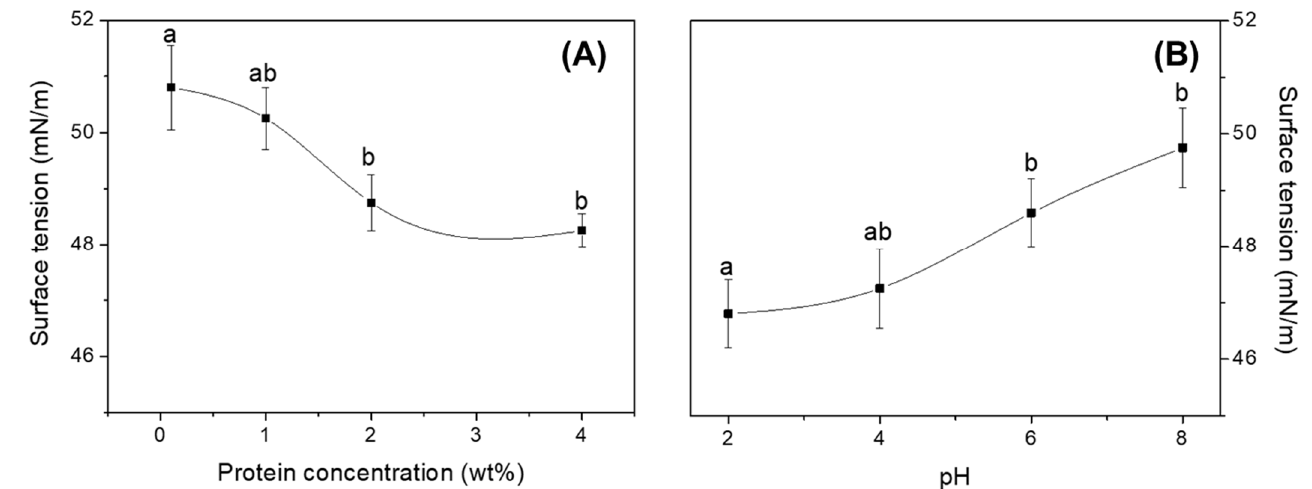
Figure 2. Surface tension values as a function of protein concentration at pH 2 ( A ) and as a function of pH at a protein isolate concentration of 2 wt% ( B ). Different letters show significant differences ( p < 0.05).